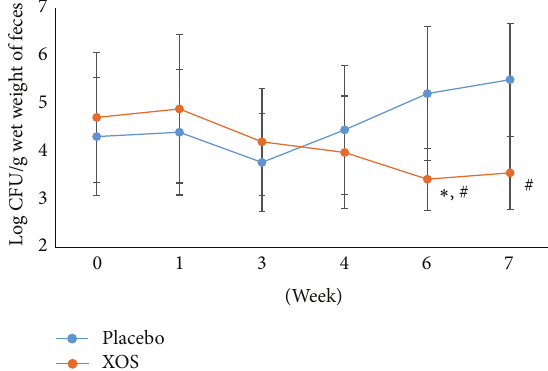
Figure 6: The changes in logarithm number (mean ± SD) of Clostridium perfringens during the trial. Weeks 0-1: a run-in phase; Weeks 6-7: a 1-week washout phase. # Repeated measures ANOVA on different groups across time. ∗ Paired t -test of week 6 versus week 0 within a group. 𝑝 < 0.05